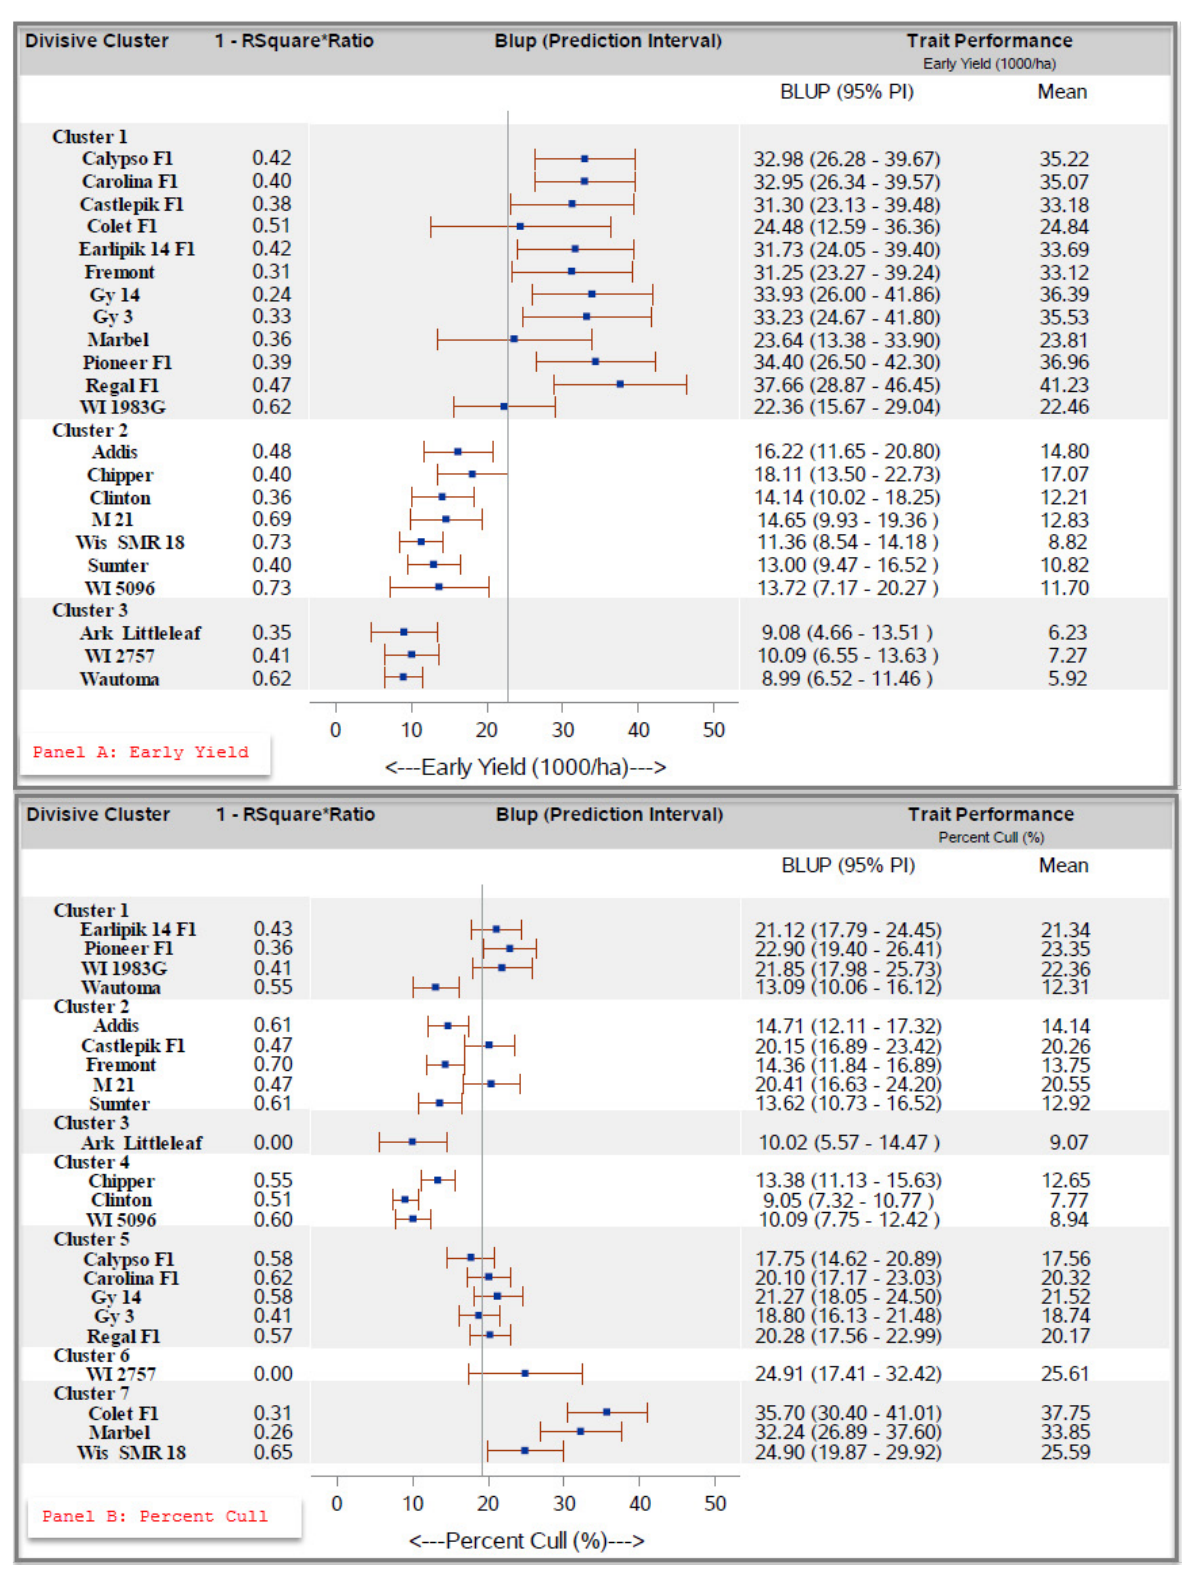
Figure 5: Divisive cluster, 1-R 2 ratio, forest plot of BLUP along with 95% prediction interval, mean, BLUP and 95% prediction interval of 22 cucumber genotypes tested in 3 years and 24 environment for early yield (Panel A) and percent cull (Panel B). Vertical line on x-axis (horizon- tal scale) represent trait mean across